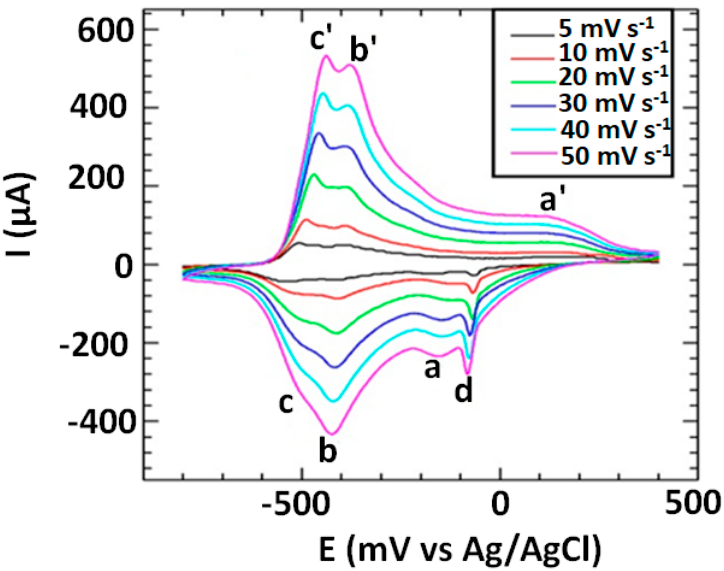
Figure 4. Scan rate dependence of the cyclic voltammetry of PDMA–PVS–Ag 0 in 1 M HCl.